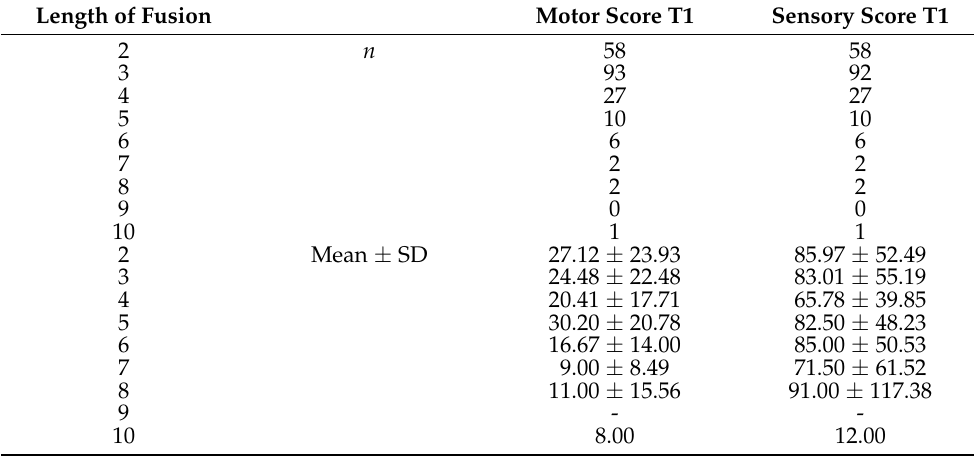
Table 4. ISNCSCI values at admission and discharge divided by fusion